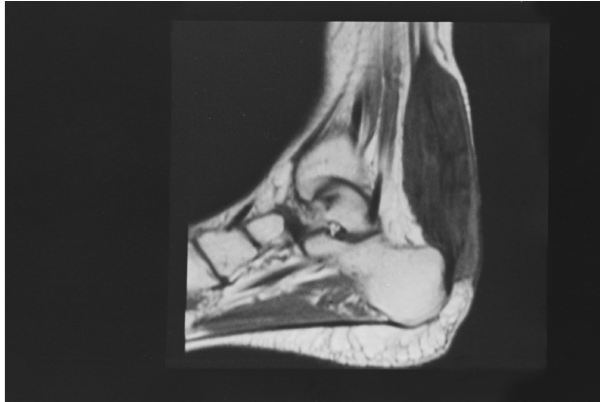
Figure 2 - Ankle MRI sagittal section in T1 showing Xanthoma of the Achilles in a patient